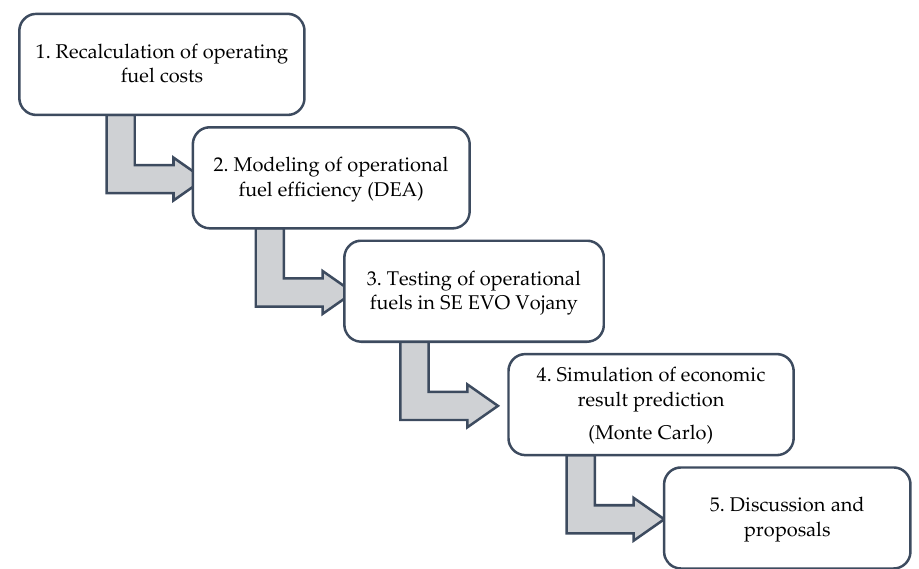
Figure 1. Methodology of case study in five steps. Source: Own processing.